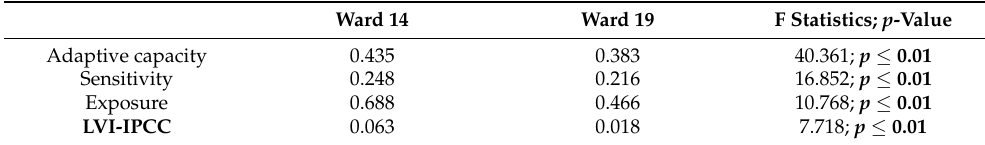
Table 2. LVI-IPCC of ward 14 and ward 19 of Chivi district.